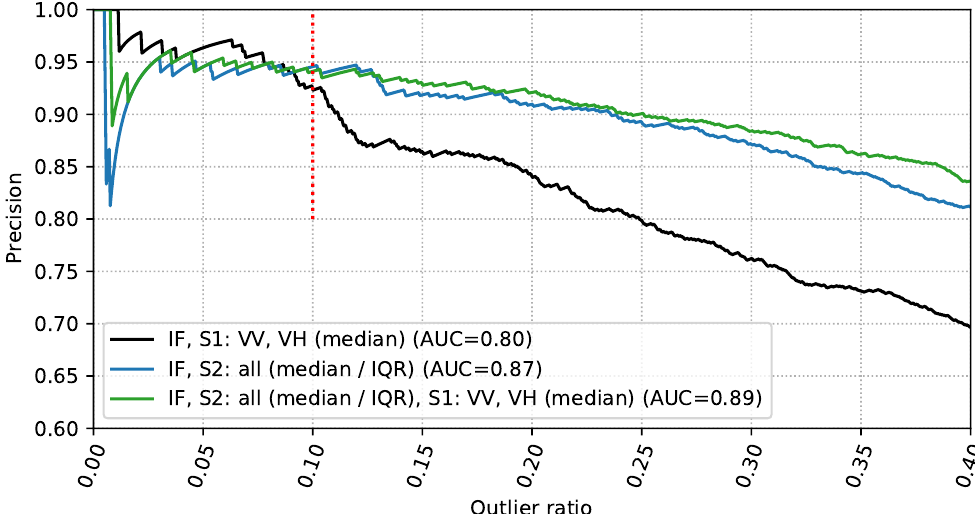
Figure 12. Precision vs. outlier ratio using the IF algorithm on the rapeseed parcels. Black: S1 features only, blue: S2 features only, green: S1 and S2 features jointly. The red line corresponds to the outlier ratio used in Figure